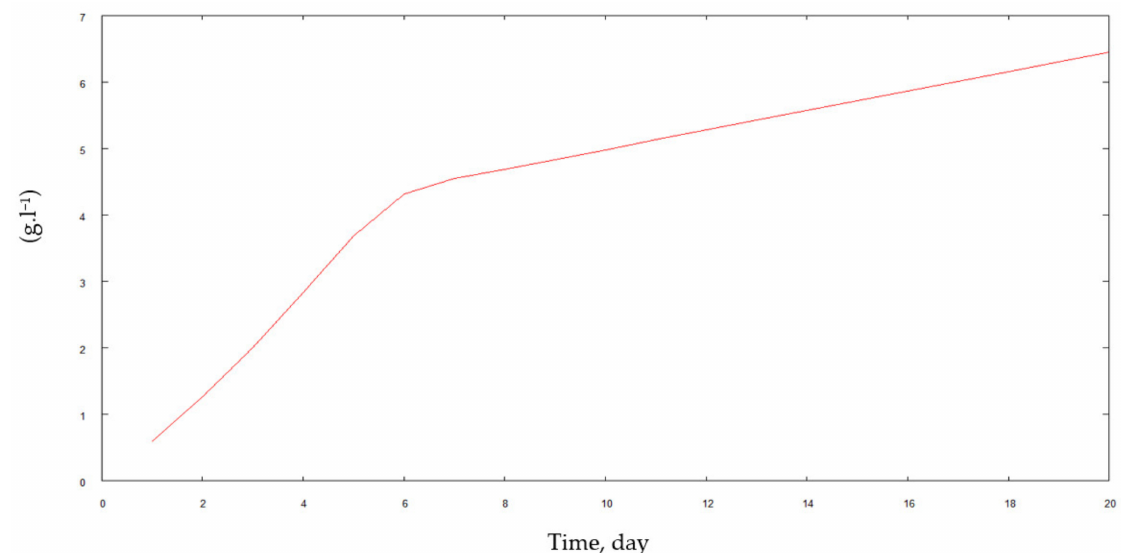
Figure 4. Methane concentration,